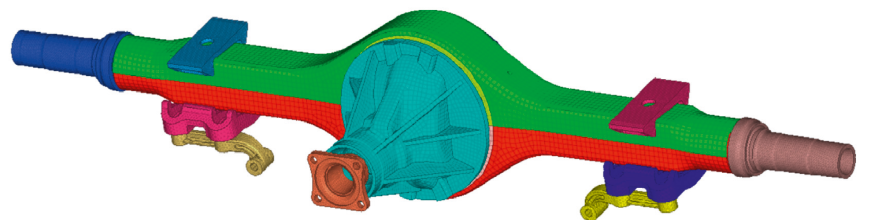
Figure 12: FEA model of rear axle.